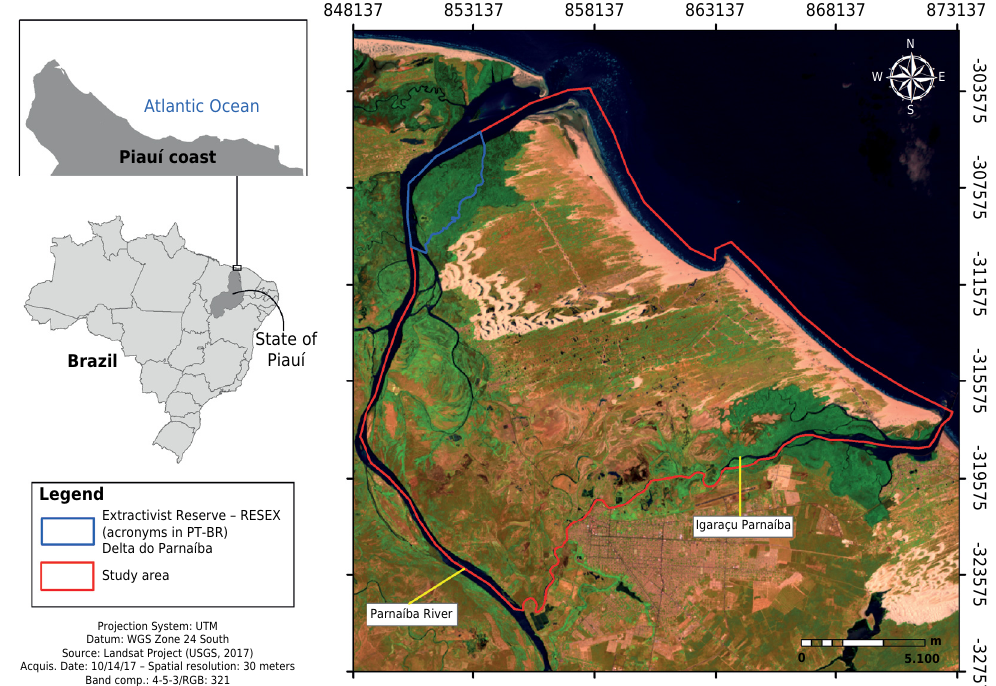
Figure 1. Location of the study